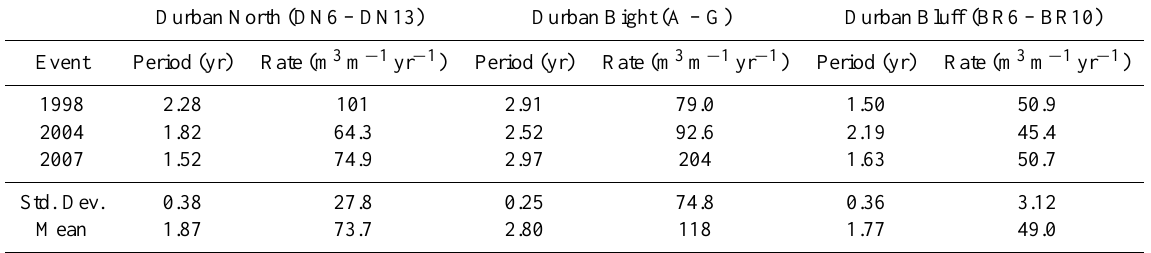
Table 1. Location averaged profile recovery periods and rates for the Durban North, Bight and Bluff blocks and for the major erosion events.